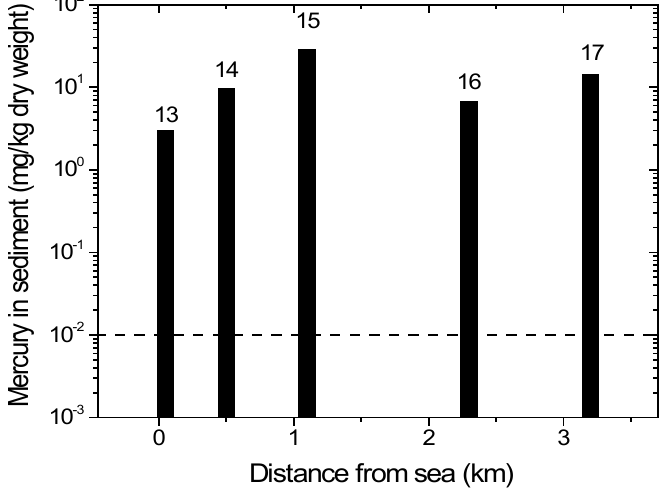
Figure 5. Mercury content in sediment from Wubudu river. Numbers on top of bars corresponds with sampling location. The dotted line indicates the recommended safety level (WHO/ICPS